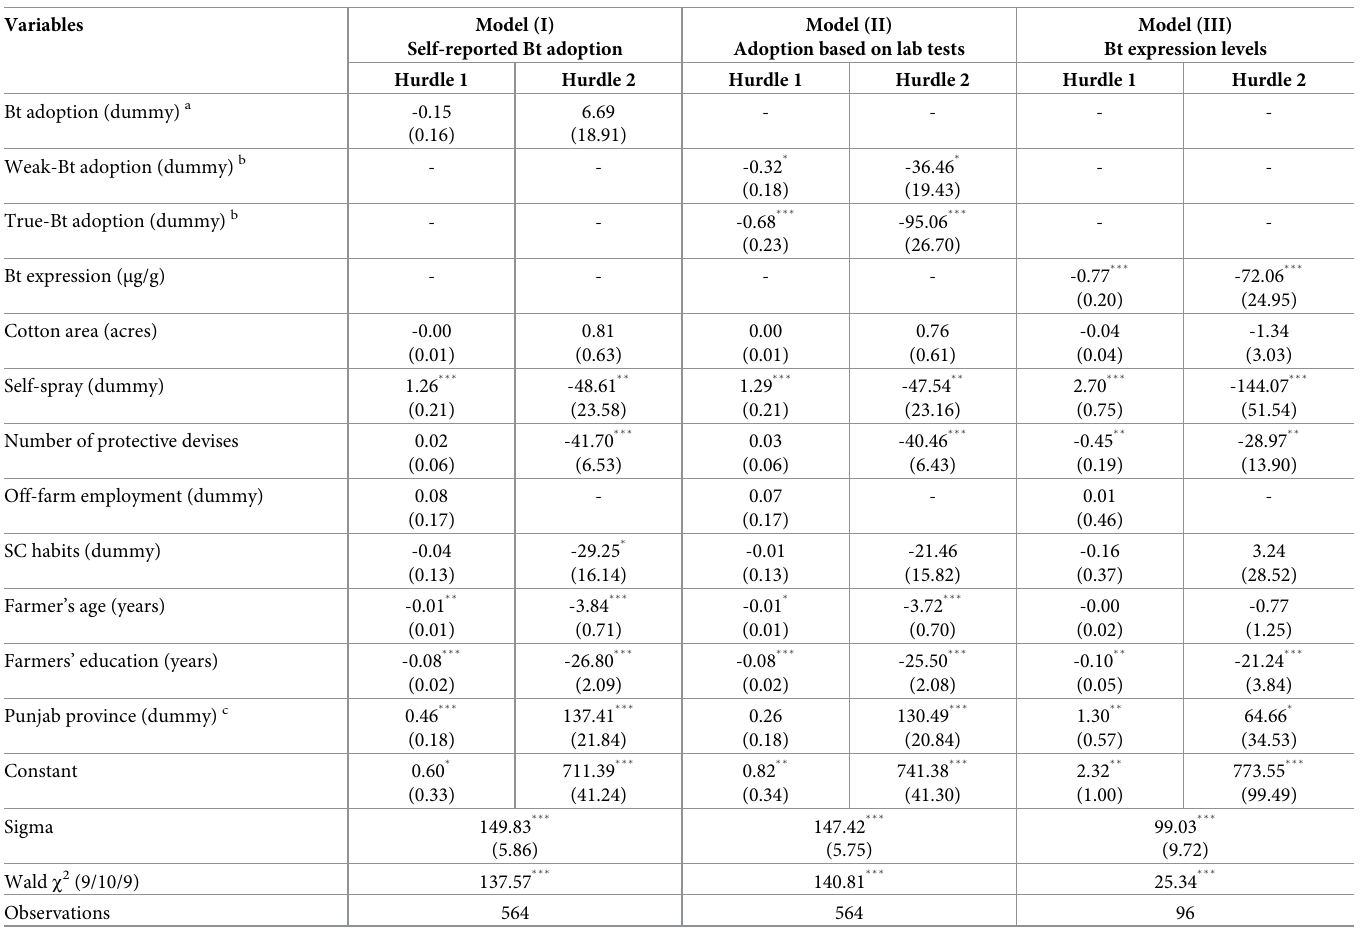
Table 5. Factors influencing farmers’ health costs (double-hurdle